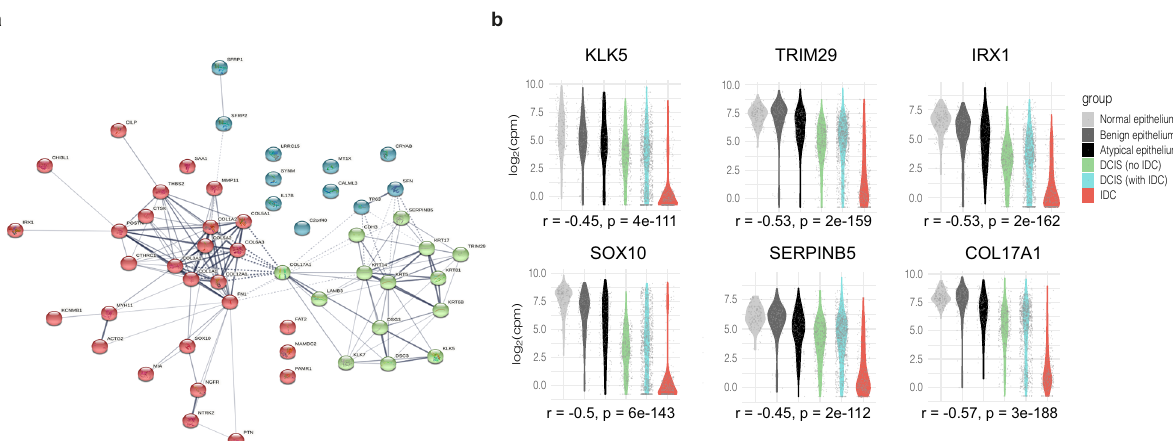
Fig. 2 Differentially expressed genes between DCIS and co-occurring IDC. a String connectivity with k-means clustering [3 clusters identi fi ed by red, green and blue] of the top 53 signi fi cant genes. b Expression distribution, in log 2 counts per million (CPM), for example genes that showed a progressive shift among different tissue groups. The Spearman rank correlation (between expression and ordered tissue groups) is given as r = rho. Two-sided p - values without correction for multiple testing are